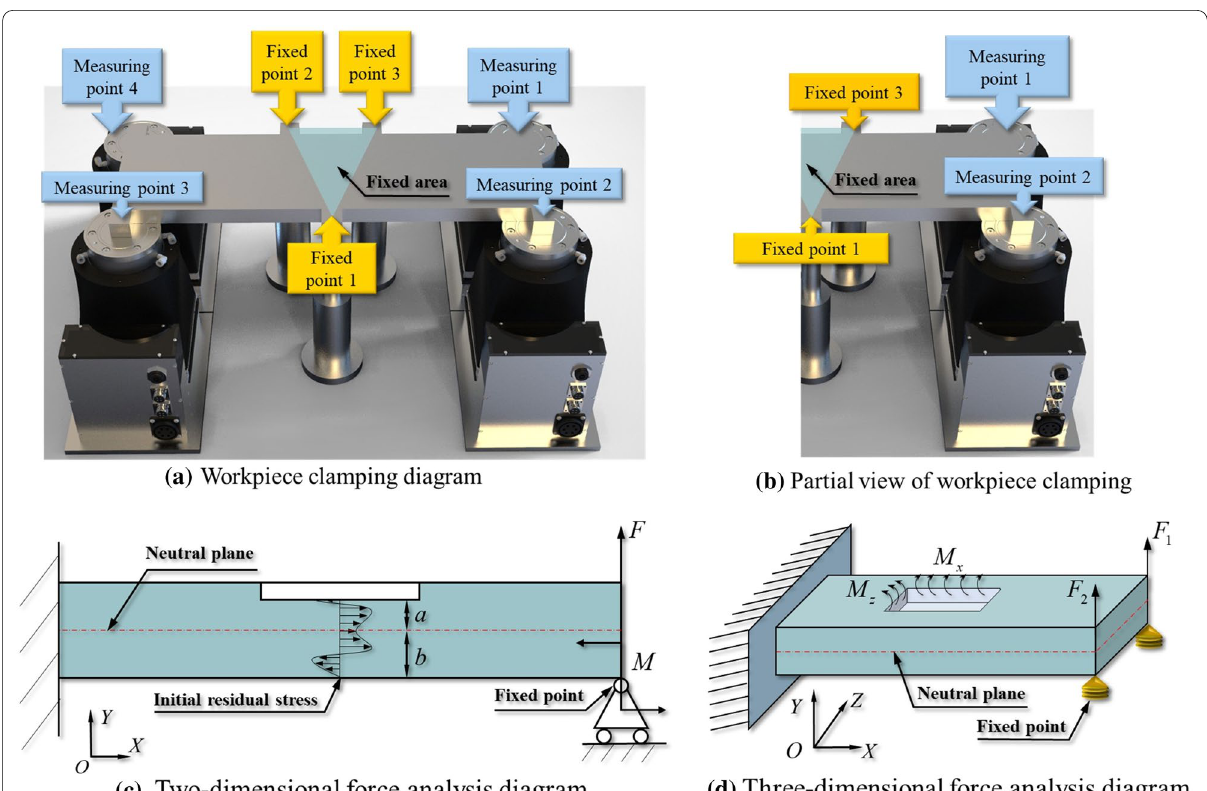
Figure 2 Workpiece clamping and deformation force